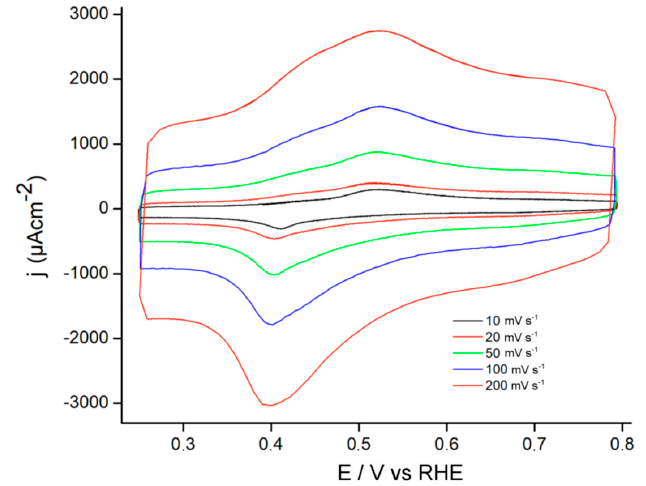
Figure 3. Stabilized cyclic voltammograms of an SWCNT@SiO 2 -PEDOT-PSS electrode in a solution of 1.0 mM FcFP 6 in 0.5M H 2 SO 4 at di ff erent scan